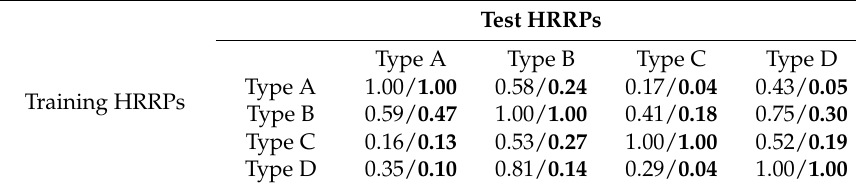
Table 4. Matching scores comparison of the five targets by O d , g r and O d , g .